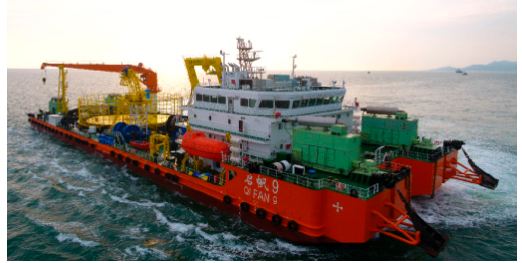
Figure 1. Qifan No. 9 with a cable capacity of 5000 tons.